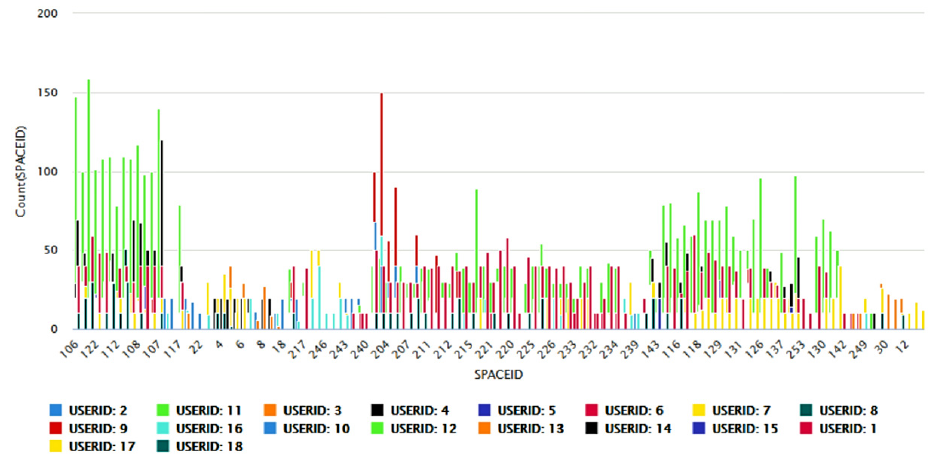
Figure 5. A bar plot representing the number of times the different users were present on specific floors in different buildings, where the plot is grouped by the value of the attribute—Floor.